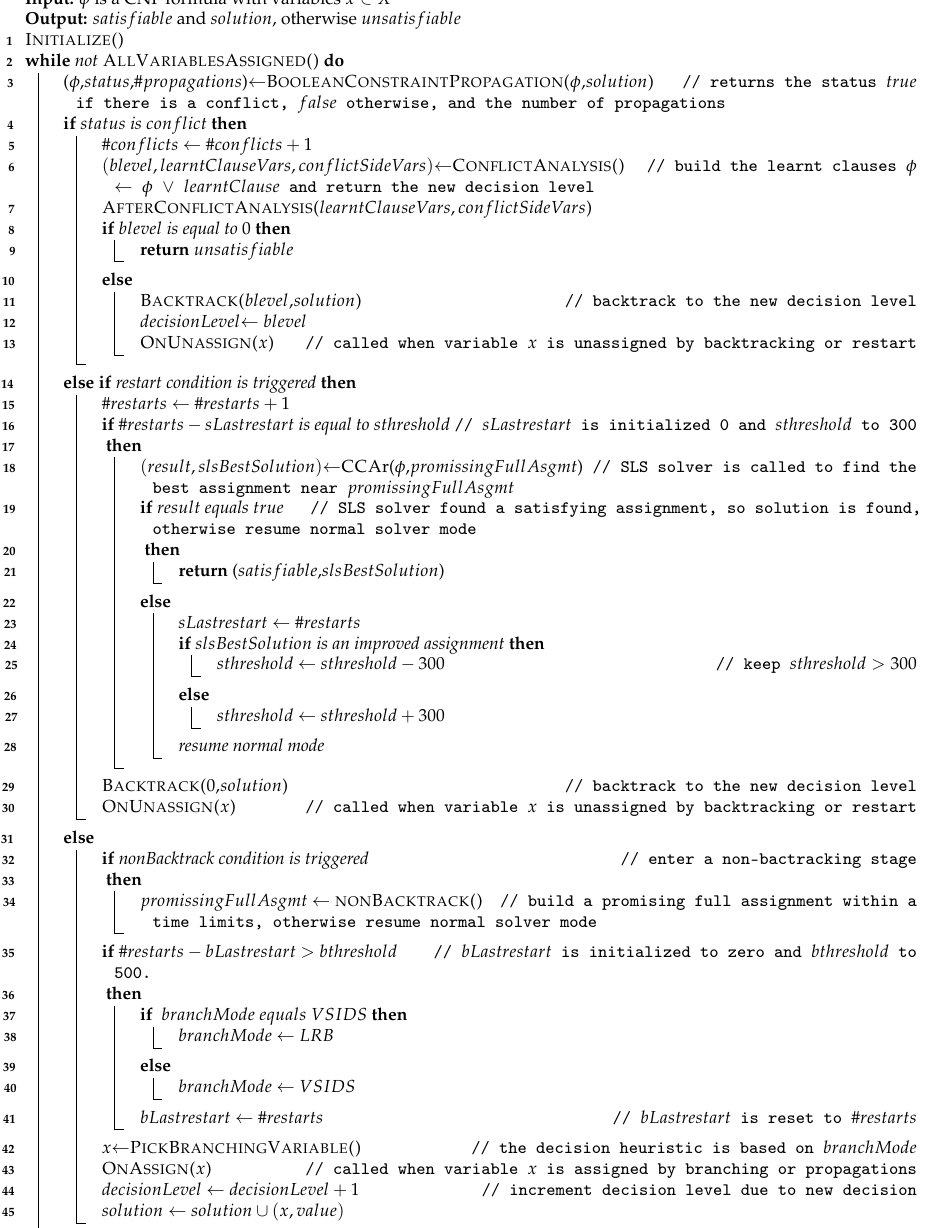
Algorithm 2: Pseudocode for top-level implementation of